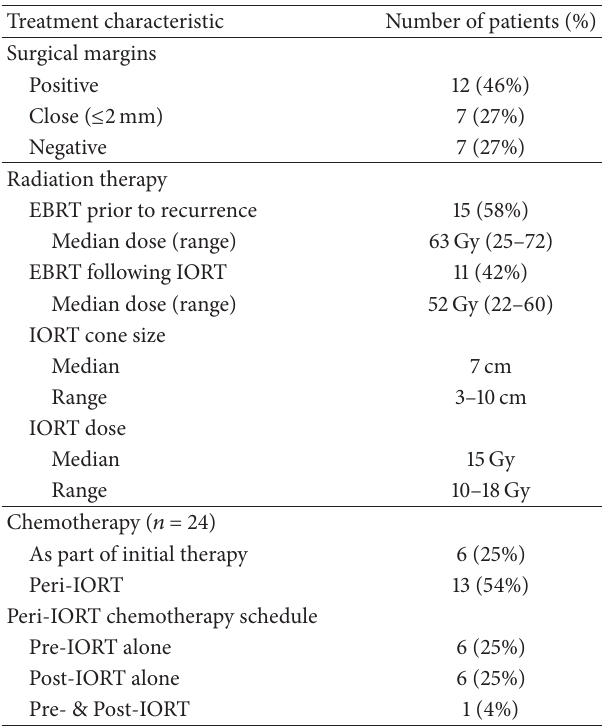
Table 2: Treatment